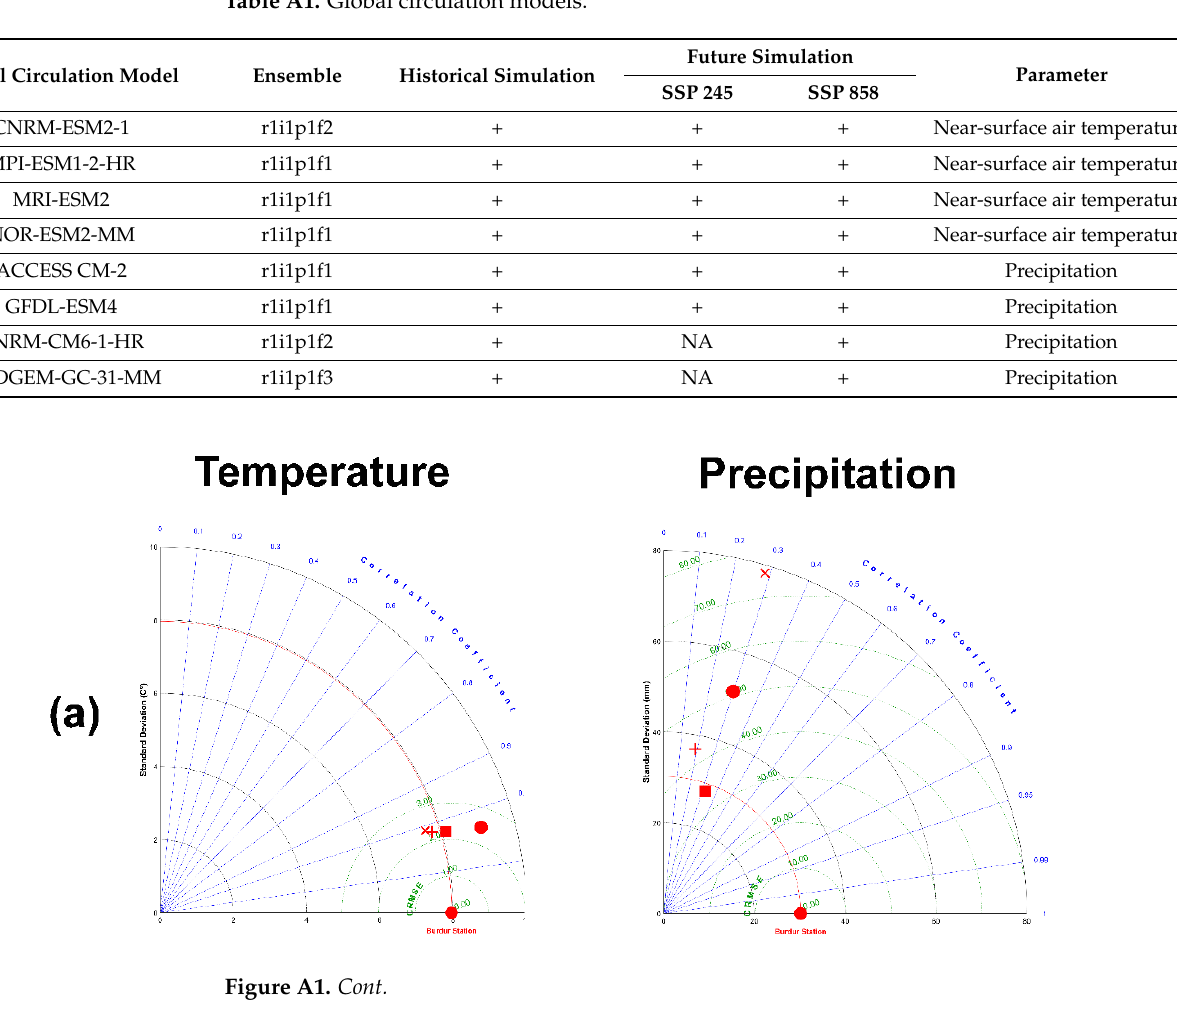
Table A1. Global circulation models.